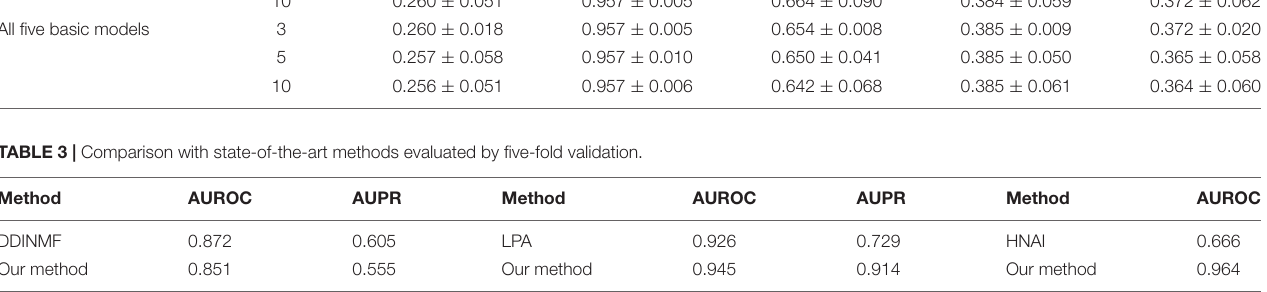
All five basic models